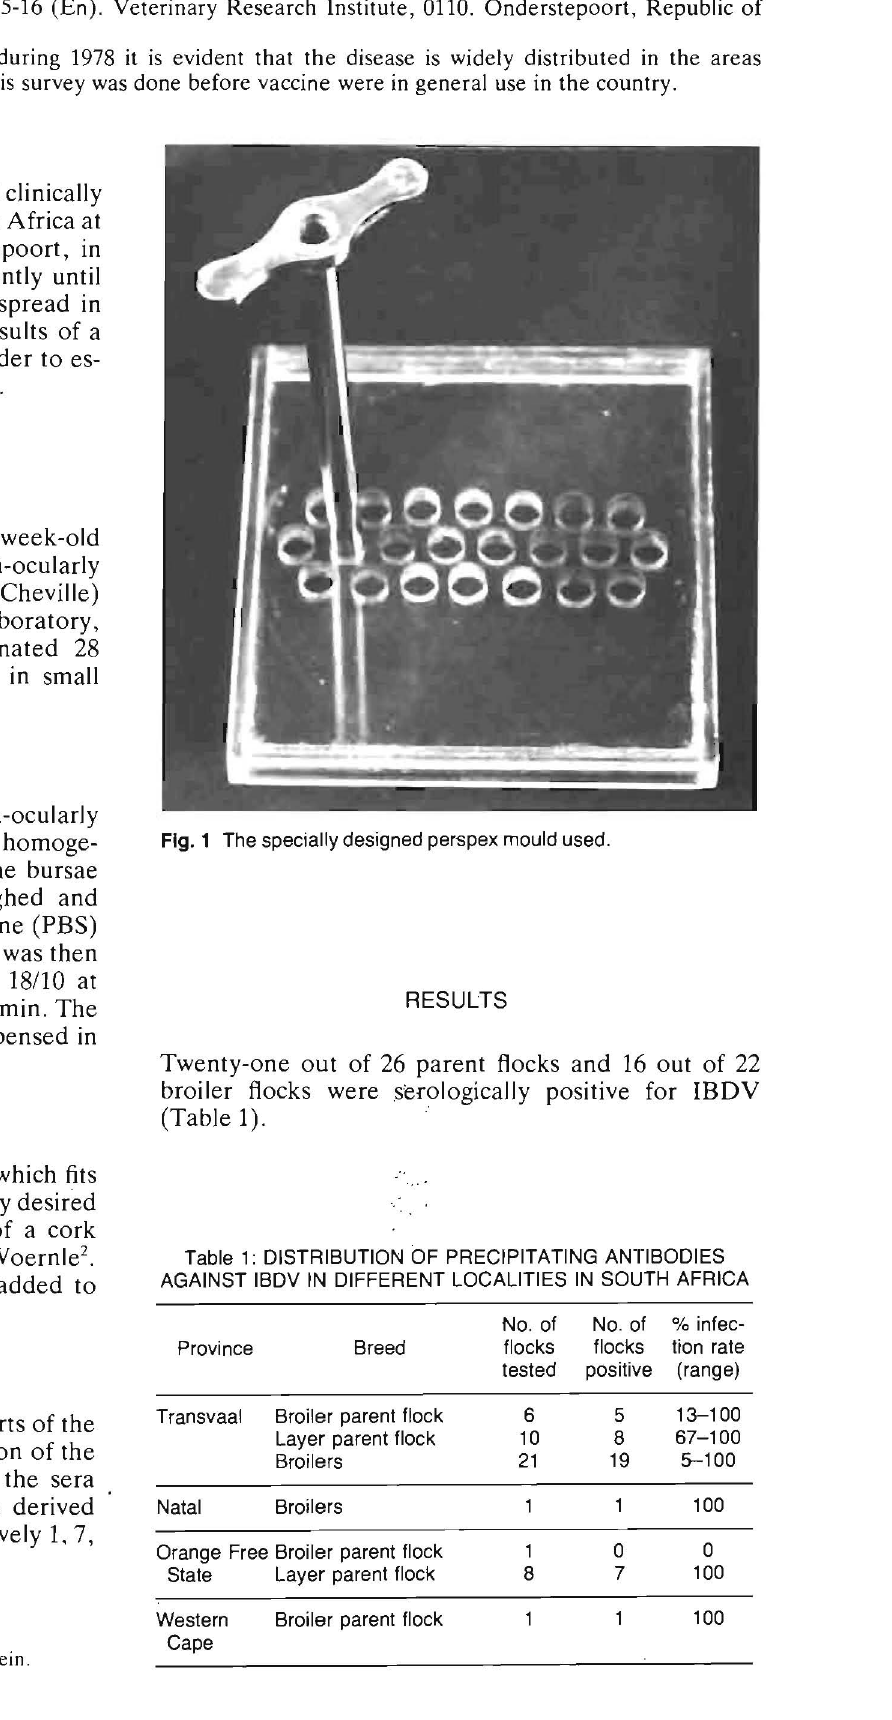
Table 1: DISTRIBUTION OF PRECIPITATING ANTIBODIES AGAINST IBDV IN DIFFERENT LOCALITIES IN SOUTH AFRICA No.